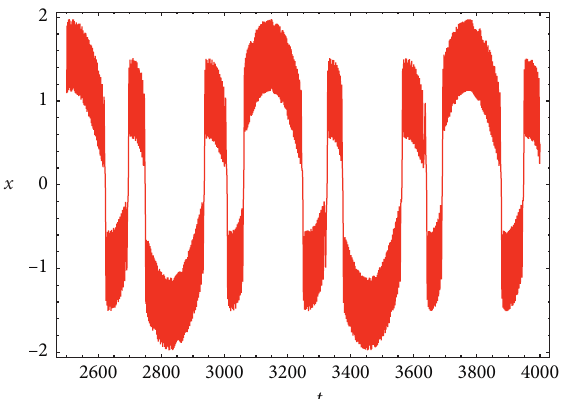
Figure 6: The time history of fast-slow system (1) at ω where the parameters are a � b � 1 , α � 0 . 1 , ω � 0 . 1, and f τ � 0 . 3 ,f 1